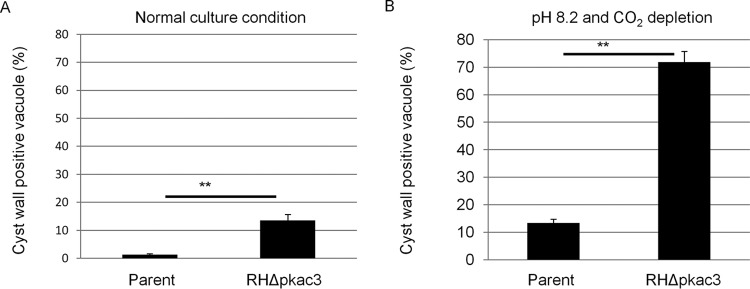
TgPKAc3 affects bradyzoite differentiation in the RH strain. The cyst wall was stained to measure the bradyzoite differentiation status in the parental parasite RHΔku80Δhxgprt (Parent) and knockout clone RHΔku80Δpkac3 (RH Δpkac3). Infected host cells were grown under normal culture conditions (A) or bradyzoite induction conditions (pH 8.2 and complete CO2 depletion) (B) for 48 h. Parasites were stained with anti-CST1 antibody and anti-Toxoplasma serum. Cyst wall-positive vacuoles were identified as parasitophorous vacuoles that have anti-CST1 signal associated with the parasitophorous vacuole. Quantitative measurements of the cyst wall-positive vacuole rate are shown. At least 100 total vacuoles per sample were counted, and cyst wall-positive vacuoles per total vacuoles are shown. Mean values and standard deviations from independent triplicate experiments are shown. Statistical differences determined by Student’s t test between parent and TgPKAc3KO are shown (**, P < 0.01).